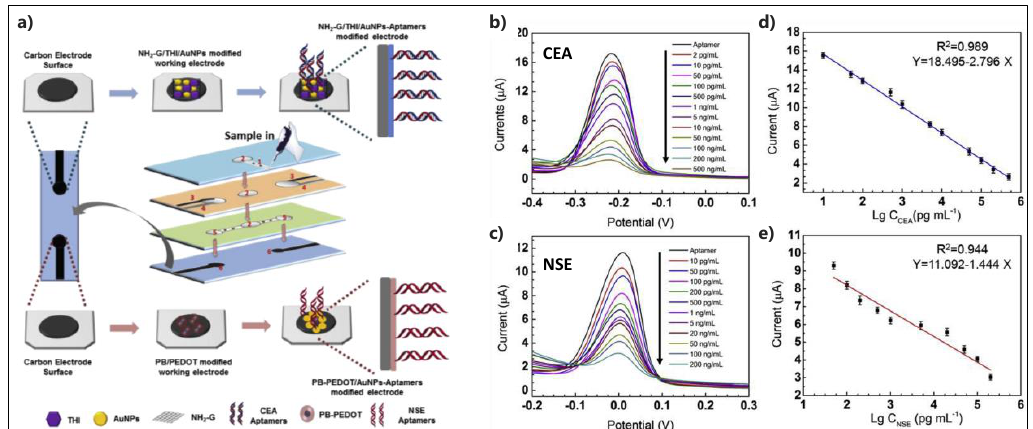
Figure 7. ( a ) Schematic design for fabrication and modification of µPAD for electrochemical detection of carcinoembryonic antigen (CEA) and neuron-specific enolase (NSE); ( b , c ) Sensor responses (DPV) to serial concentrations of CEA and NSE, respectively; and, ( d , e ) Corresponding calibration curves of peak currents as the function of logarithmic concentrations of CEA and NSE, respectively. Reproduced with permission from [90]. Table 2. Graphene-based electrochemical biosensors for protein cancer biomarker detection. The underlined terms are the bioreceptors.